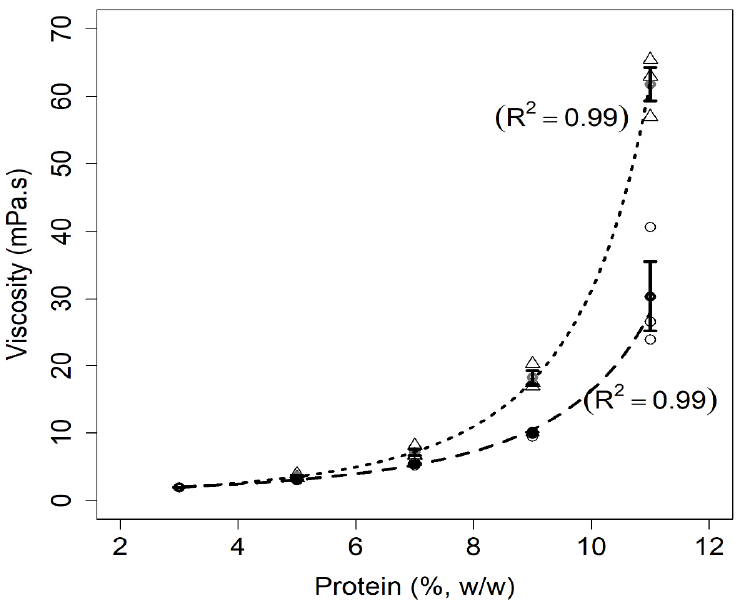
Figure 2. Relationship between viscosity and protein concentrations for milk (dashed line) and mixed protein (dotted line) samples. The figure shows the data points for milk (circles) and mixed samples (triangles), error bars (SE), fitted curves, and adjusted coefficients of determination (R 2 ).